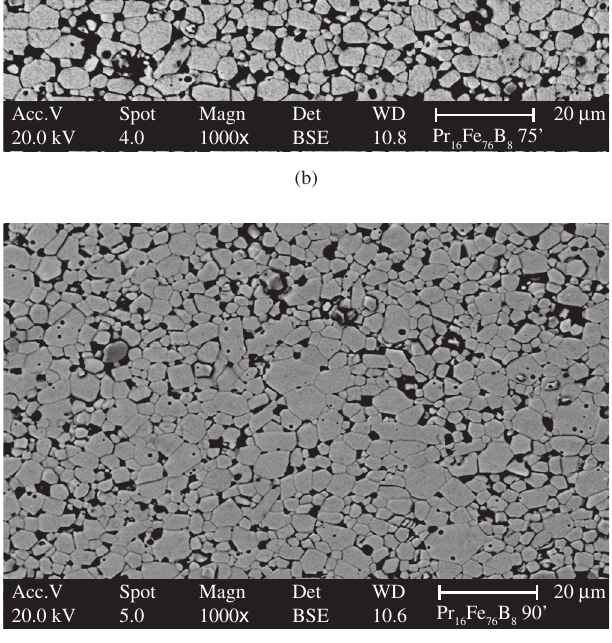
Fe B magnet produced 16 76 8